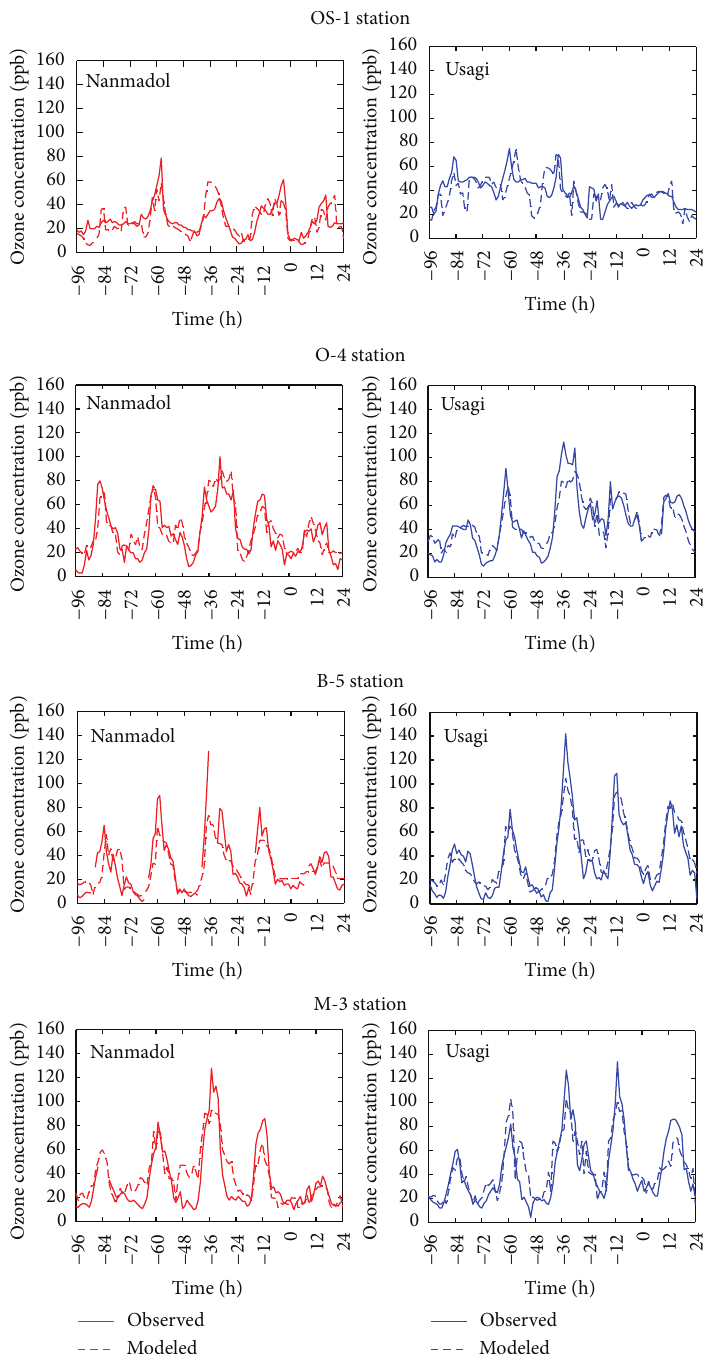
Figure 6: Both observed (O) and modeled (M) ozone concentration in the ambient air in Southern Taiwan before and after issuing sea warning for both typhoons Nanmadol and Usagi (August 24 ∼ 28, 2011, for Nanmadol and September 16 ∼ 20, 2013, for Usagi); Magong (OS-1), Linyuan (O-4), Dailao (B-5), and Pingtung (M-3) stations. (Time = 0 is the time for issuing sea warning for typhoons.)